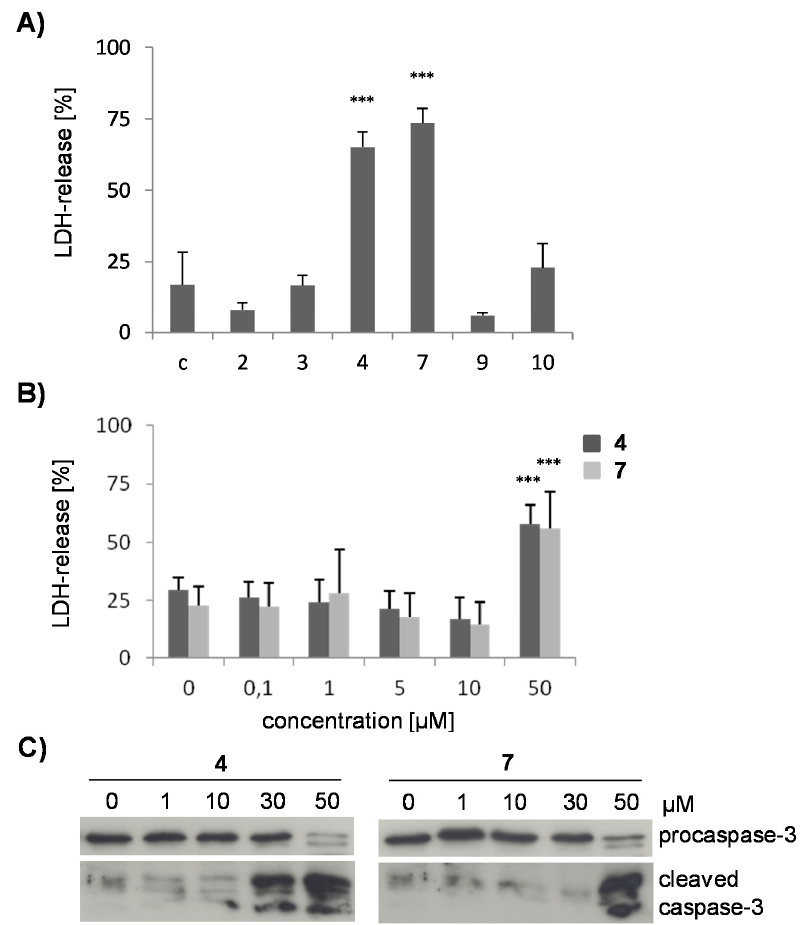
Figure 2. Cytotoxicity of flavonoids from D. duckeana . Cell damage was determined by an LDH ‐ release assay after incubating SK ‐ N ‐ SH cells with the flavonoids 2 – 4 , 7 , 9 , and 10 at 50 μ M ( A ) or with the compounds 4 and 7 at concentrations from 0.1–50 μ M ( B ) for 24 h. Values represent means ± s.d. of three ( A ) or four ( B ) independent experiments. Statistical evaluation was performed by one ‐ way ANOVA (in A ) or two way ANOVA (in B ), followed by the Bonferroni post hoc test. ***, p < 0.001 vs. untreated control cells. In ( C ), SK ‐ N ‐ SH cells were treated with 1–50 μ M of compound 4 or 7 for 6 h before cellular lysates were analyzed for pro ‐ caspase ‐ 3 cleavage by immunoblotting. A representative blot is shown ( n = 3).